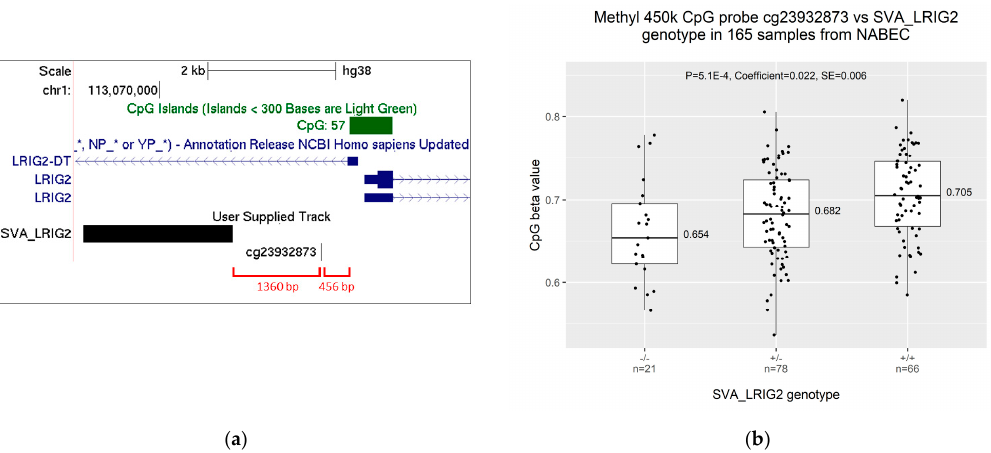
Figure 5. ( a ) The LRIG2 promoter region as displayed on UCSC genome browser hg38, with two validated LRIG2 isoforms and first exon of LRIG2-DT shown by the RefSeq genes curated subset. The position of SVA_LRIG2 is displayed in black. The position of cg23932873, the CpG probe closest to SVA_LRIG2, is shown in black and the LRIG2 promoter-associated CpG island is shown in green. The distances in base pairs from cg23932873 to SVA_LRIG2 and the CpG island are shown in red. ( b ) Frontal cortex CpG 450K methylation data for probe cg23932873 in 184 NABEC individuals grouped by SVA_LRIG2 RIP genotype. A total of 96 genotypes were PCR validated and 88 were imputed for a total of 184 genotypes. Int. J. Mol. Sci. 2020 , 21 , x FOR PEER REVIEW